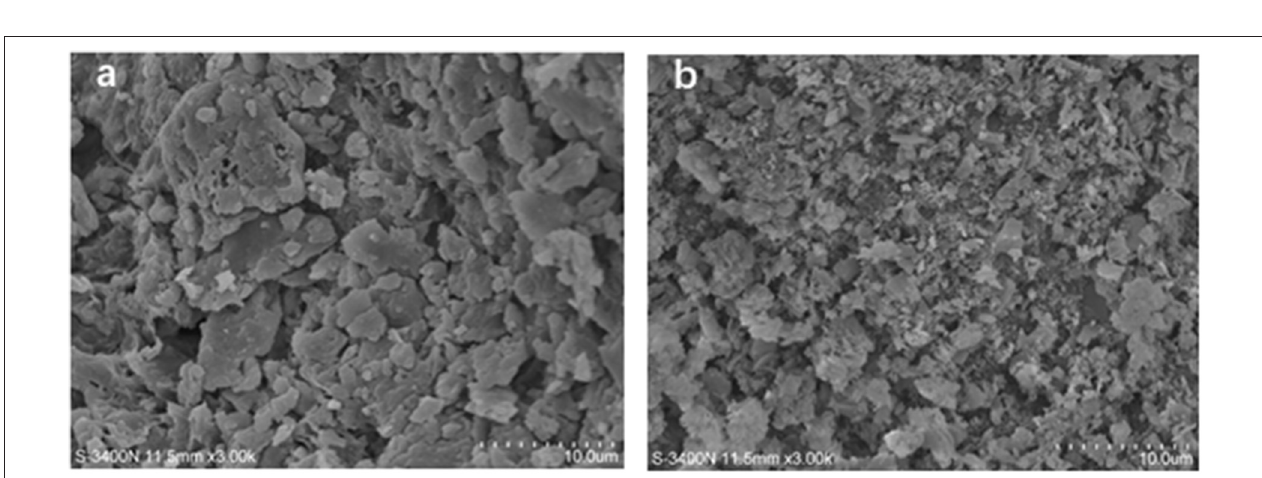
FIGURE 7 | The cumulative weight fraction of the SDF from orange peel [ (A) Control-SDF, (B) PEF-SDF]. PEF treatment parameters: electric field intensities 6.0 kV/cm, the number of pulses 30, the extraction time of 20min, liquid-solid ratios of 15:1 and temperature of 45 ◦ C.